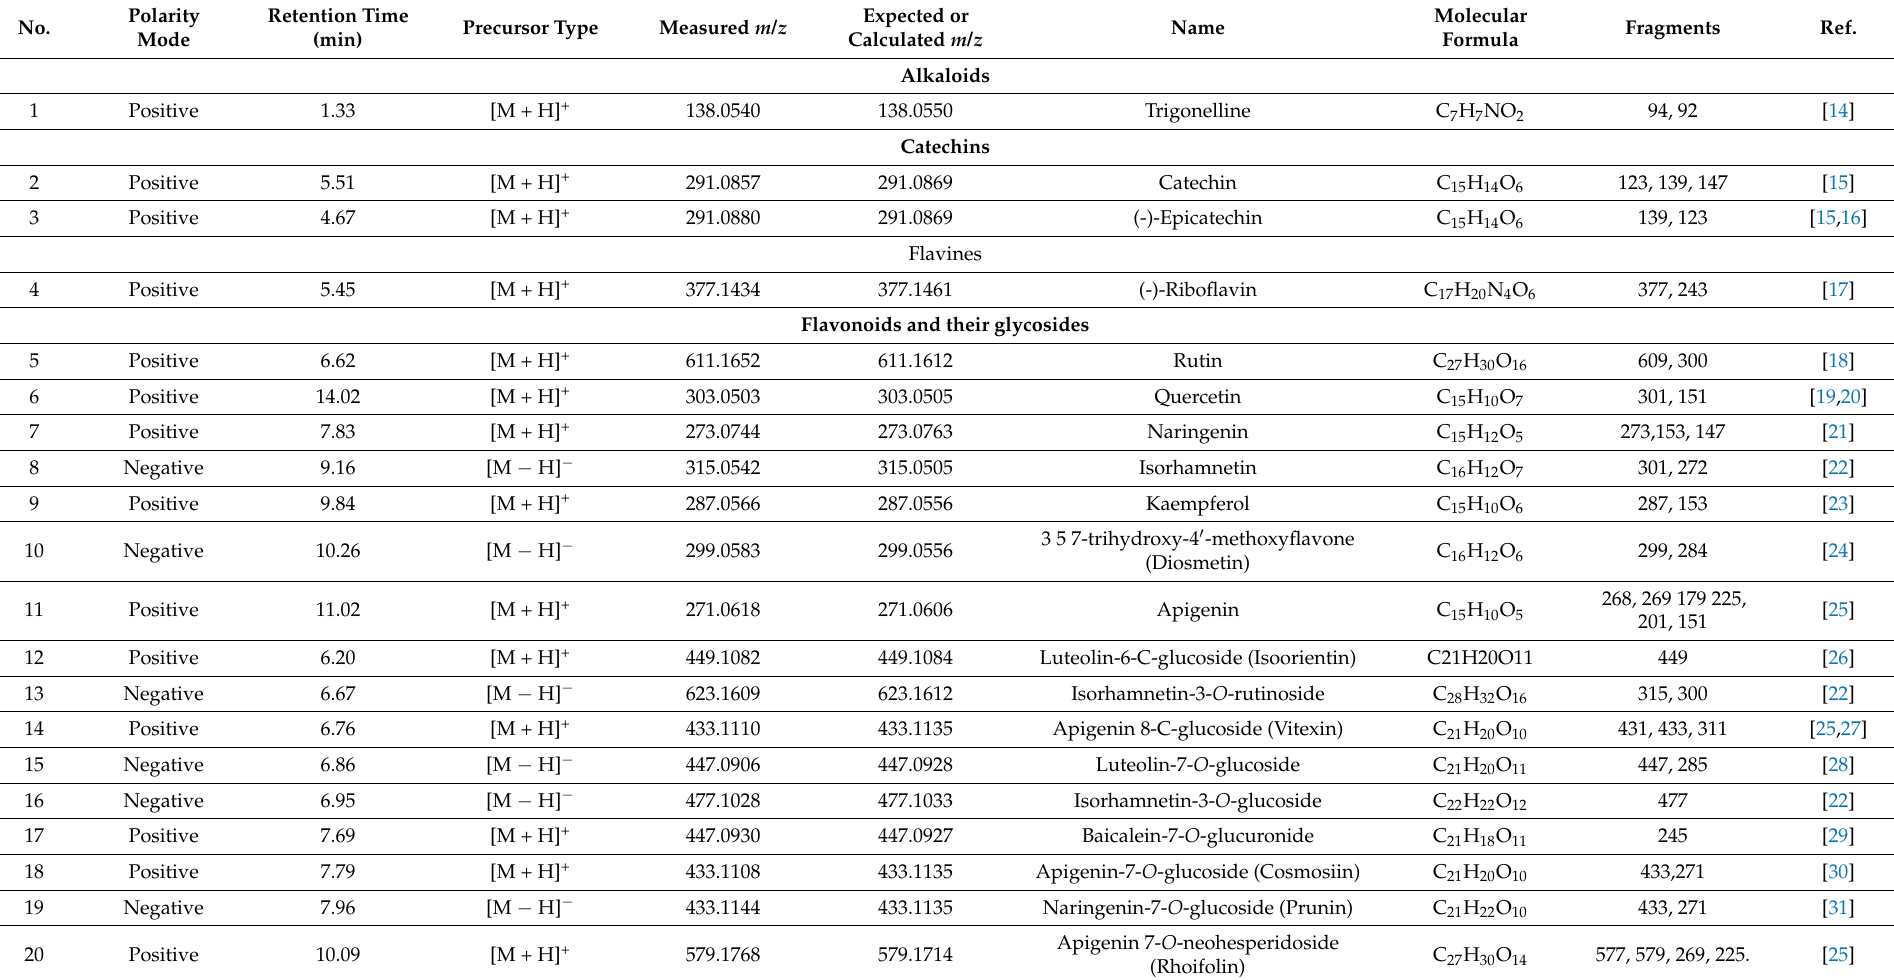
Table 1. LC-MS/MS metabolic analysis of M. alysson L. methanolic